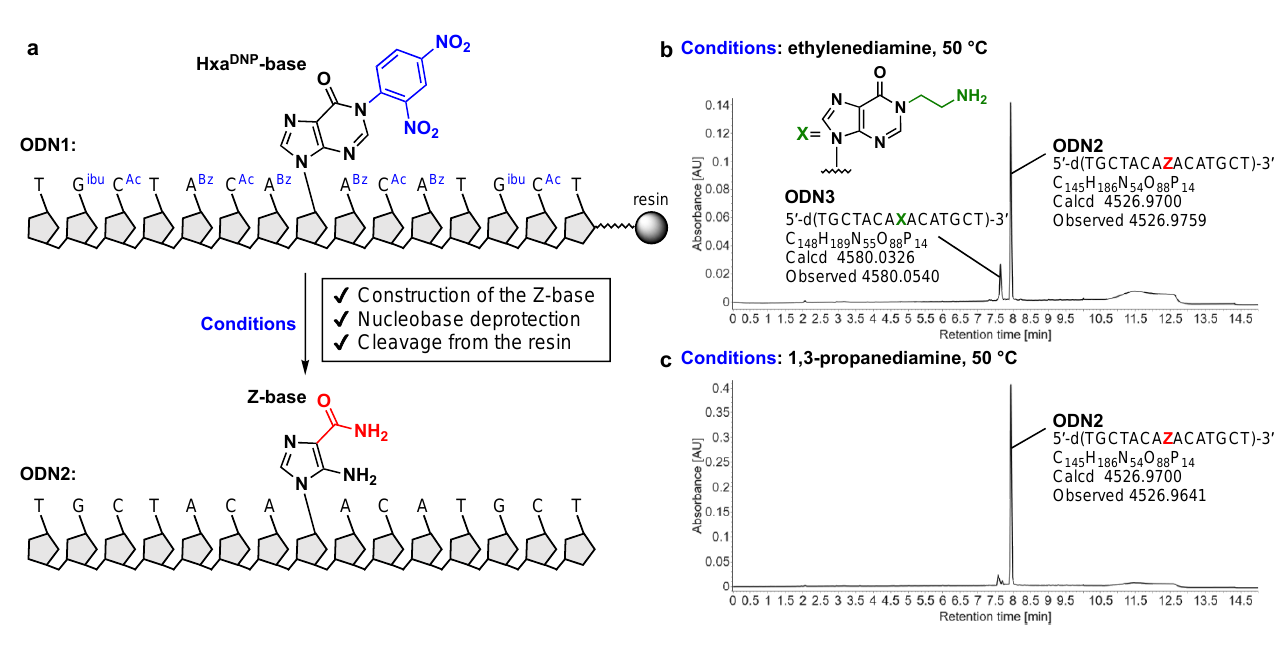
Figure 2. Preparation of ODNs containing Z-base. ( a ) Schematic procedures for Z-base construction on a support-bonded ODN, and LC-MS analysis after treatment by ( b ) ethylenediamine at 50 °C, and ( c ) 1,3-propanediamine at 50 °C. Samples were analyzed by UPLC using a BEH C18 column (Waters, 2.1 × 50 mm, 1.7 μm) eluted with linear gradient from 5% to 40% MeOH with 3.5 mM triethylamine (TEA), 40 mM 1,1,1,3,3,3-hexafluoro-2-propanol (HFIP) (0.3 mL/min for 15 min). A Bz , N 6 -benzoyladenine; G ibu , N 2 -isobutyrylguanine; C Ac , N 4 -acetylcytosine.